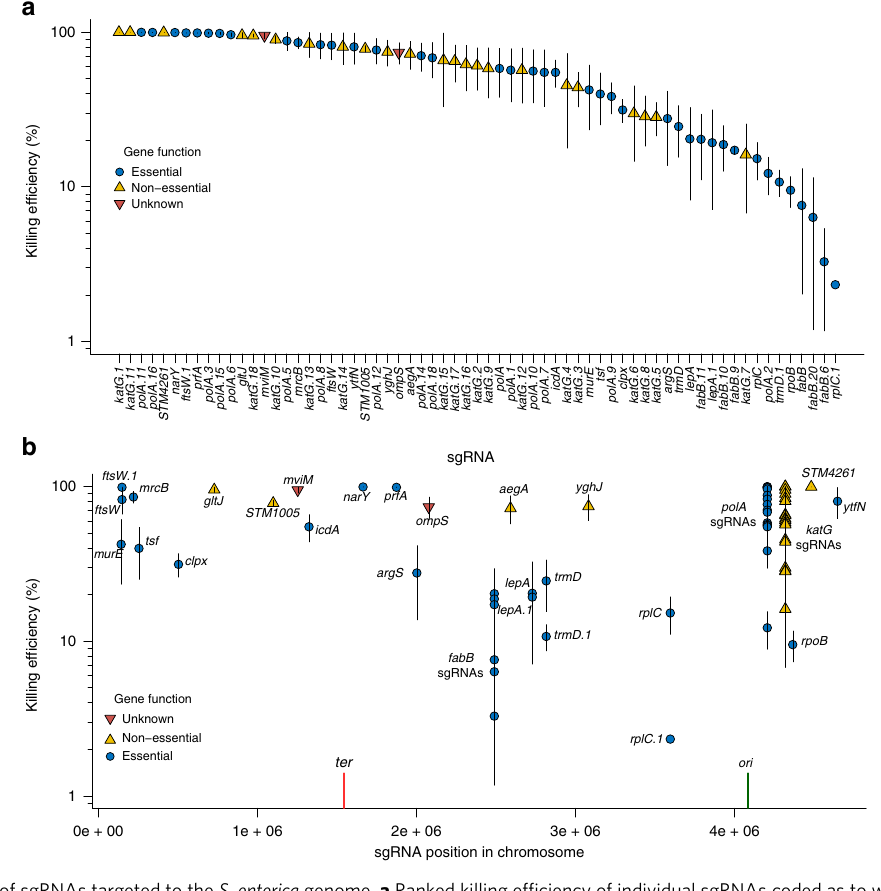
Fig. 3 Killing ef fi ciency of sgRNAs targeted to the S . enterica genome. a Ranked killing ef fi ciency of individual sgRNAs coded as to whether the target site in found in an essential gene (blue fi lled circles), nonessential gene (orange diamonds), or unknown if the gene is essential (inverted red triangles). Vertical lines represent the standard error of the data from at least three biological replicates. b Killing ef fi ciency of each sgRNA plotted relative to their position in the S . enterica genomes, color-coded as in panel a . The terminator region ( ter ) and origin of replication ( ori ) are indicated by vertical red and green lines, respectively. Source data are provided as a Source Data fi